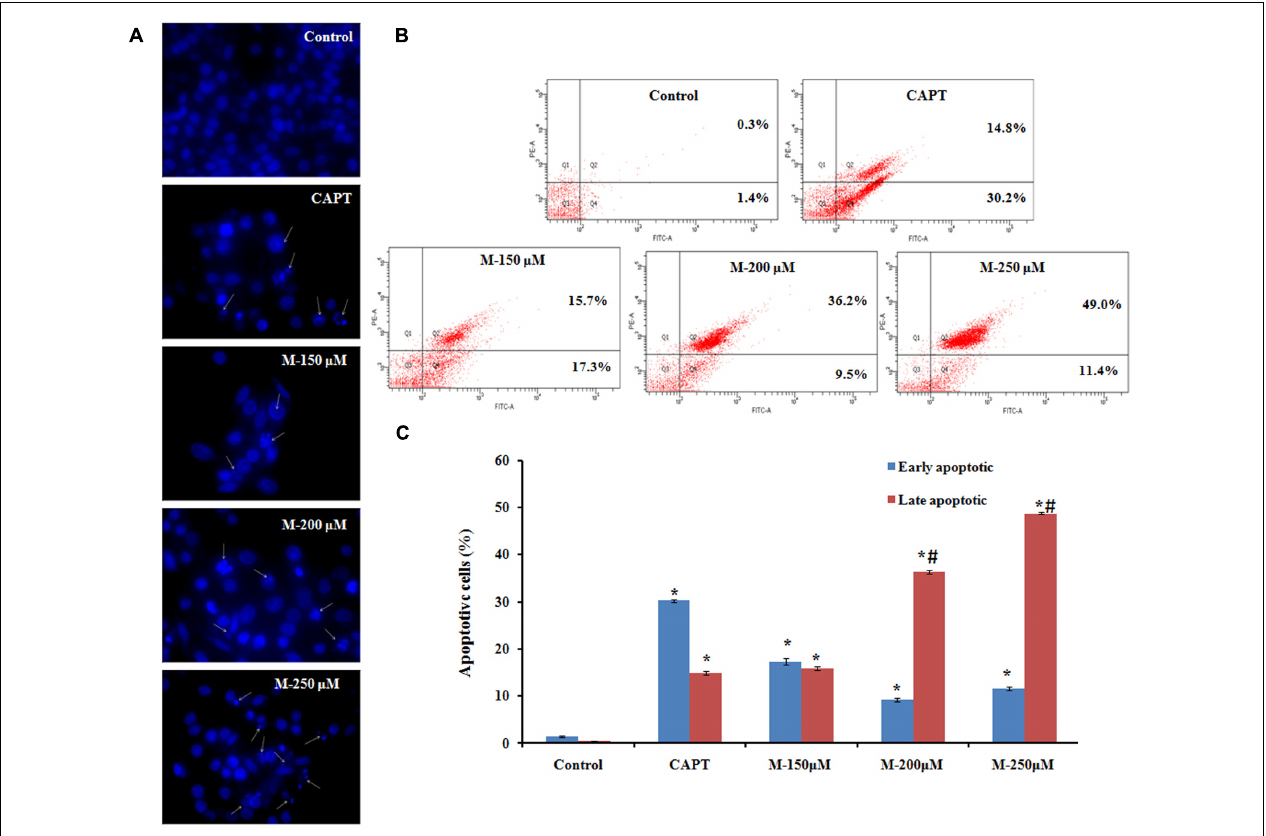
FIGURE 3 | Effect of morin on apoptosis.SW480 cells were treated with various concentrations of morin (150, 200, and 250 µ M) and camptothecin (50 µ M) for 48 h. (A) Chromatin condensation and nuclear fragmentation observed using Hoechst 33342 staining, arrows represent cells with chromatin condensation inside the nucleus or fragmentation of the nucleus. (B) Annexin V-FITC/propidium iodide staining and flow cytometric analysis of cells undergoing apoptosis. (C) Flow cytometry analysis of the percentage of apoptotic cells in each group. CAPT: camptothecin (50 µ M), M (150, 200, and 250 µ M): Morin (150, 200, and 250 µ M). Significance levels between different groups were determined by using one way ANOVA, followed by Duncan’s multiple range test. ∗ p ≤ 0.05 versus control, # p ≤ 0.05 versus